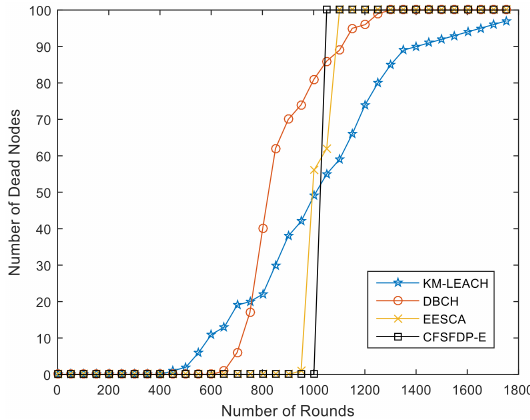
Figure 8. Network Lifetime Comparison of KM-LEACH, DBCH, EESCA, and CFSFDP-E.